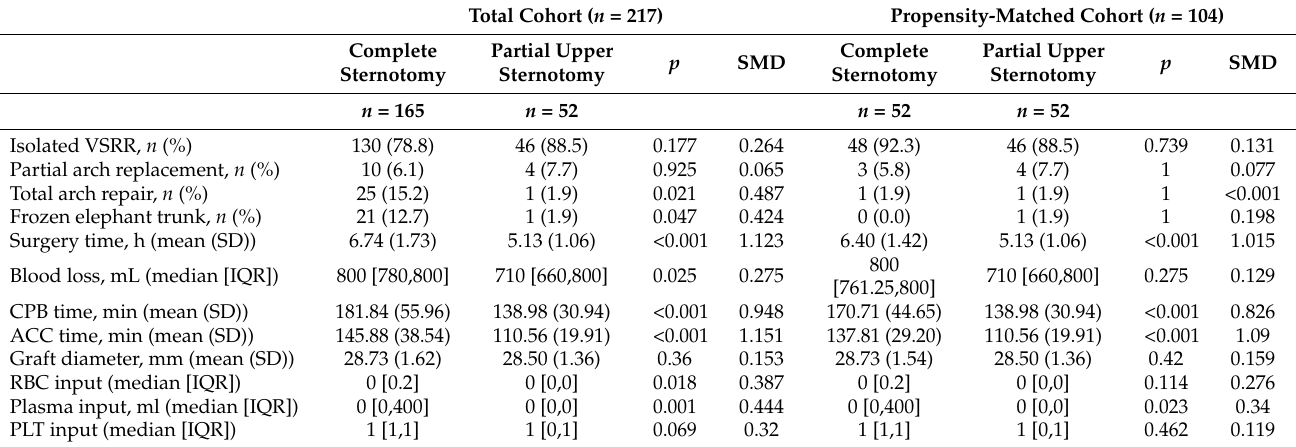
Table 2. Perioperative data of the total cohort and propensity-matched cohort. Total Cohort ( n = 217) Propensity-Matched Cohort ( n = 104)